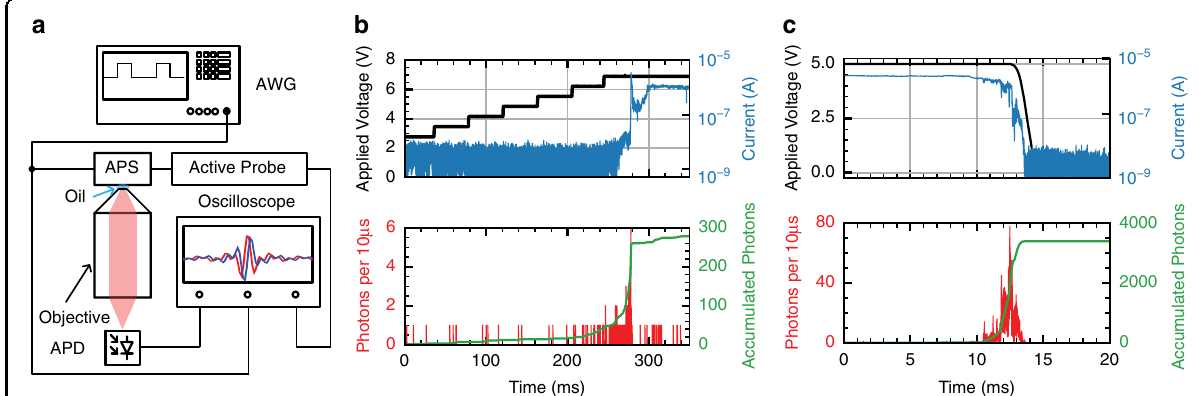
Fig. 2 APS Electroluminescence Measurement. a The setup of the measurement. The APS sample is placed on top of an inverted microscope and is imaged by using an oil immersion objective. An avalanche photodiode records the optical activity of the device. A voltage bias is applied to the device under test (APS) by an arbitrary wavefunction generator (AWG). The current and the emitted light are measured synchronously by an oscilloscope. b Upper panel: current evolution upon fi lament formation. The applied voltage is gradually ramped up to 7 V, shown in the black curve. At ~280 ms, the current increases abruptly from the noise fl oor of ~10 nA to several μ A, shown in the blue curve. Lower panel: corresponding photon activity. A burst of photons can be seen upon the abrupt increase of current. Both the photon rate and accumulated photon counts are plotted. Red curve: binned photon counts with a size of 10 μ s. Green curve: accumulated photon counts. Most photons are generated within the transient switching time at around 280 ms. c Emission from fi lament dissolution, a burst of photons can be seen upon the abrupt current drop at around 12 ms. Photon counts are binned every 10 μ